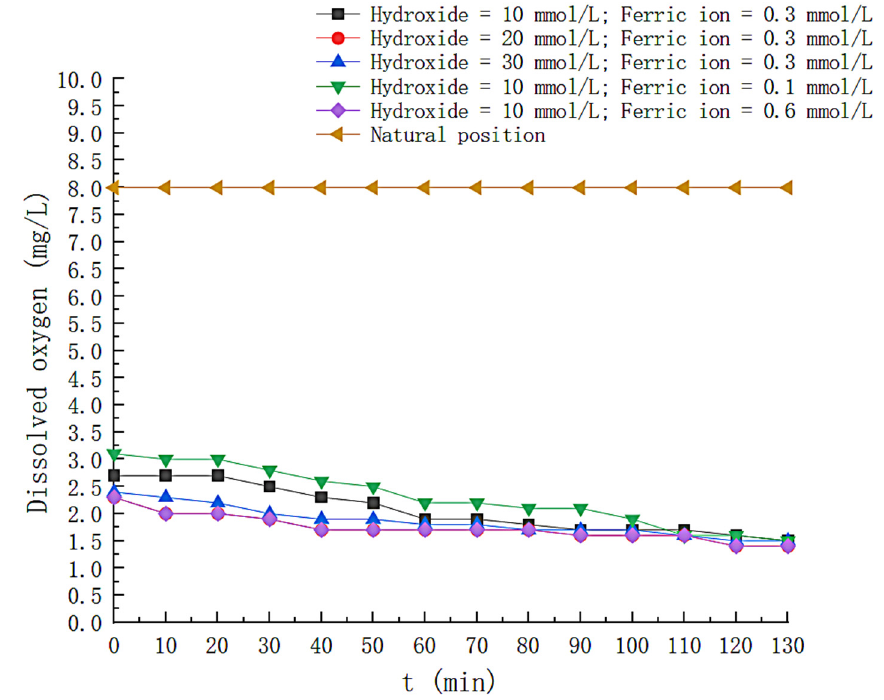
Figure 13. Variation of dissolved oxygen under different conditions.